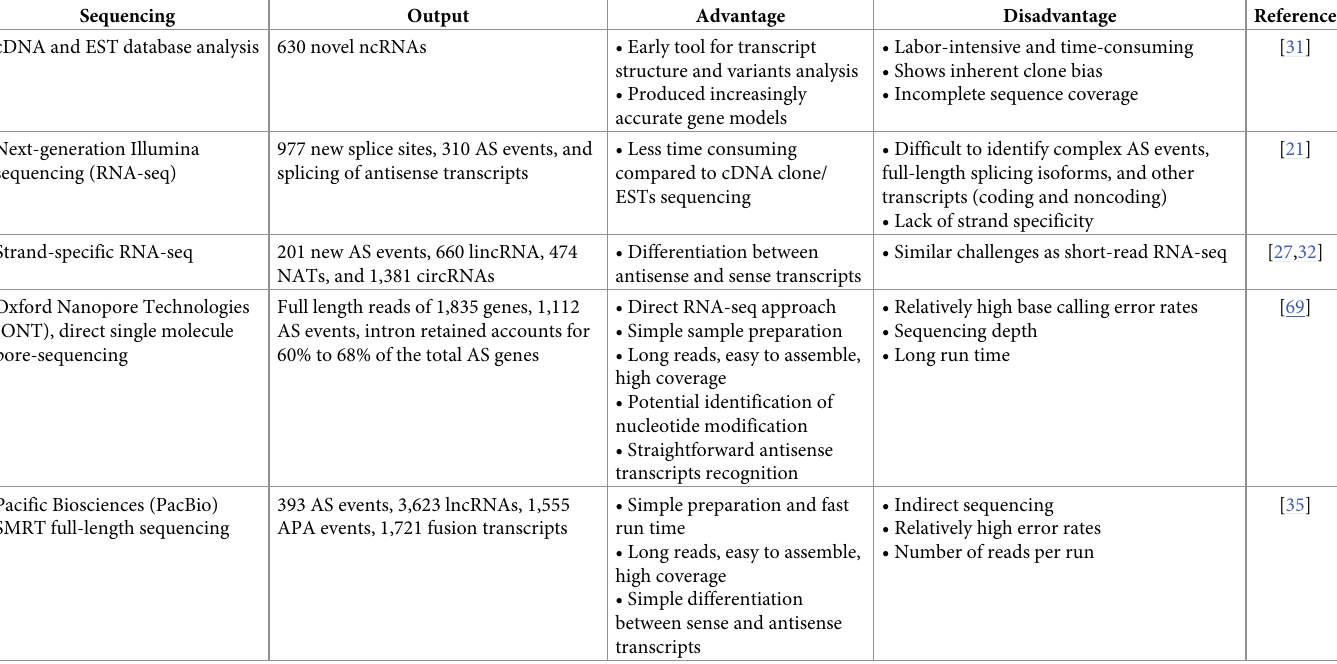
Table 1. Various sequencing techniques used to study ncRNAs in P . falciparum